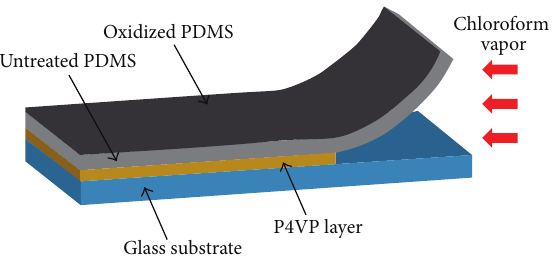
Figure 1: A schematic illustration of uniaxial rolling of the PDMS bilayer detached from the P4VP coated glass substrate upon expo- sure to the chloroform vapor.